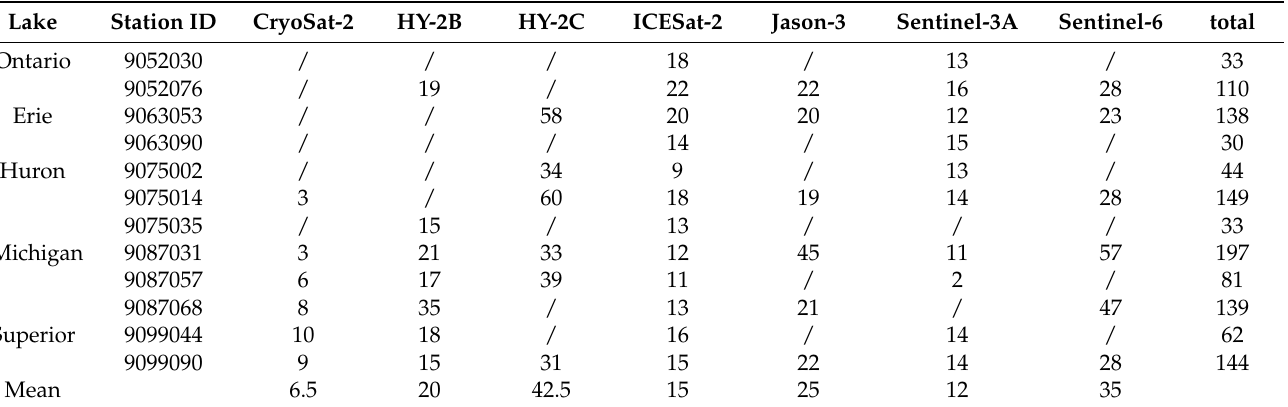
Table 8. The number N of measured water levels by seven altimetry satellites at twelve stations in the Great